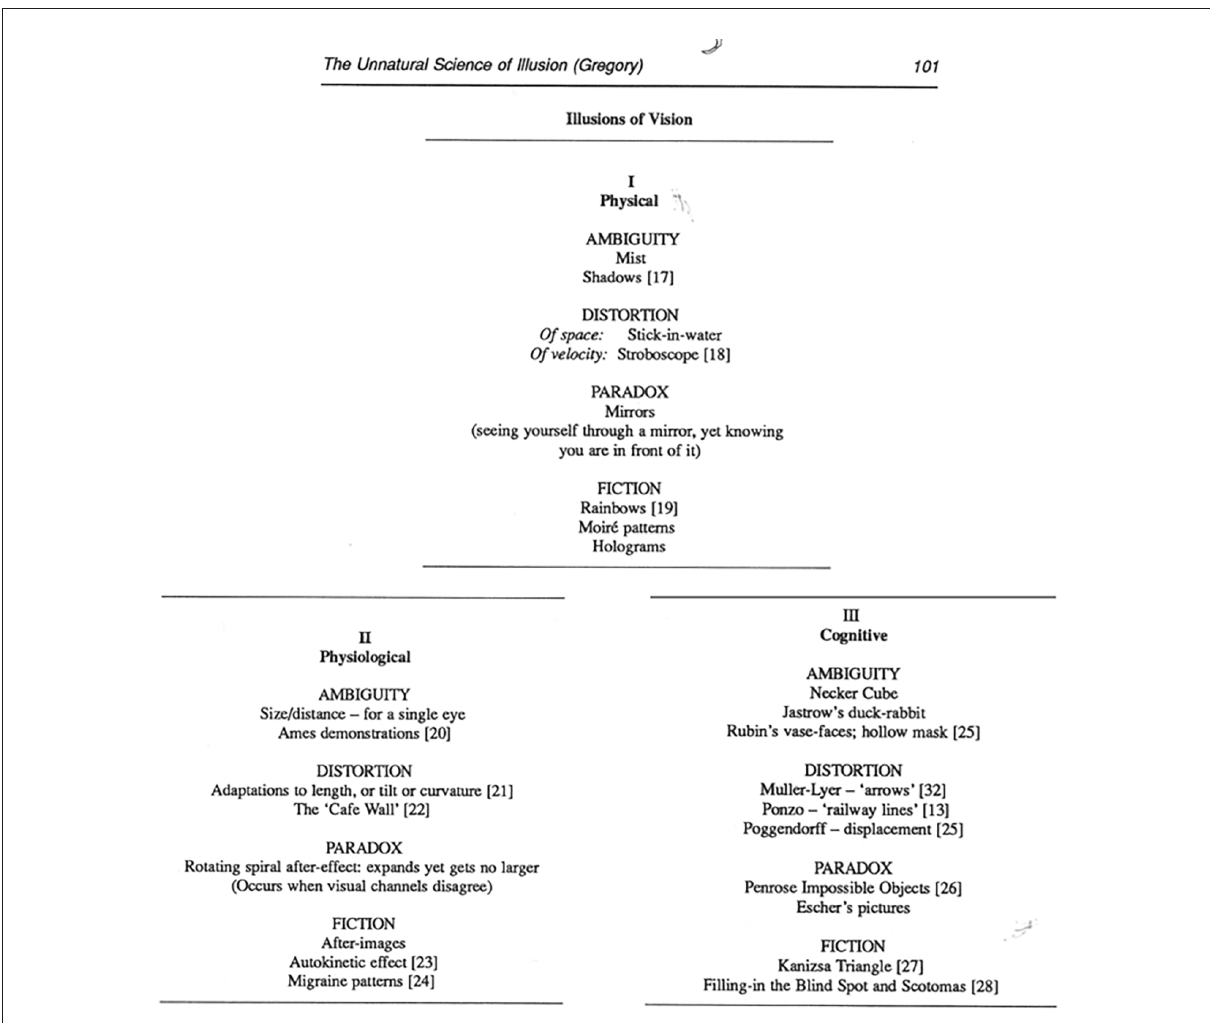
FIGURE1 Gregory’s (1966) classification based on the cause of the illusion: Physical, Physiological or Cognitive.